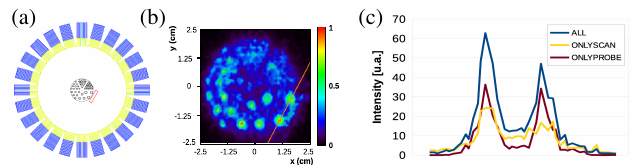
Fig. 2: GATEv8.2 simulations of the probe and the Preclinical Super Argus PET/CT. (a) Gate simulation setup. (b) Source reconstruction. (c) Source reconstruction profiles.